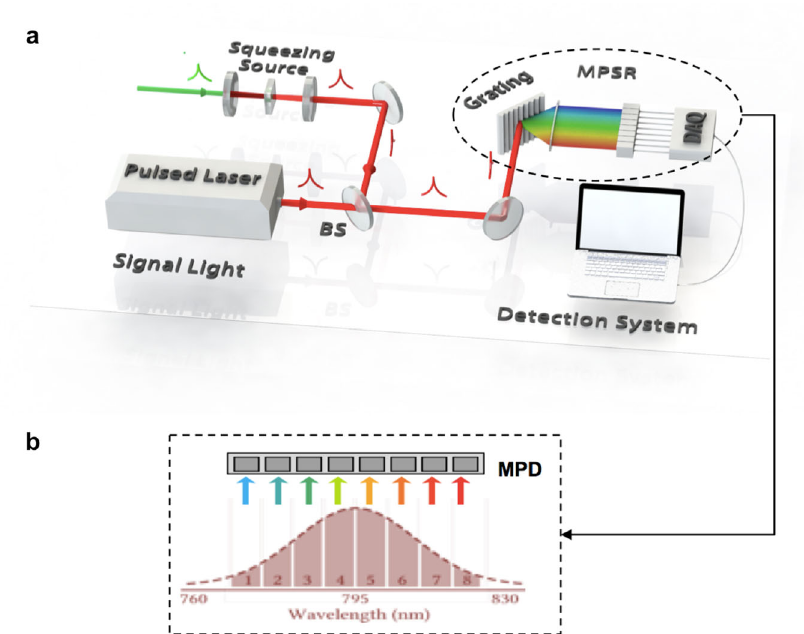
Fig. 2 Experimental set-up. a The simultaneous multimode measurement of frequency, energy and spectral bandwidth fl uctuations within a laser fi eld. All three parameters are modulated within the pulsed laser cavity. A multimode squeezing resource is then employed which allows enhancing the measurement of these quantity beyond the standard quantum limit. This is accomplished by mixing the squeezer with the laser fi eld via a strongly re fl ective beam splitter. The resultant synthetic beam is spectrally dispersed and imaged onto a photodiode array after passing a micro-lenses array. The photocurrents corresponding to each of the eight pixels are transferred to a computer for post-processing. BS beam splitter, 10/90; grating has 93% ef fi ciency; MPSR homemade multi-pixel spectrally resolved detector. b The corresponding spectral bins of equivalent width are simultaneously interrogated with an eight-pixel photodiode array. MPD multi-pixel